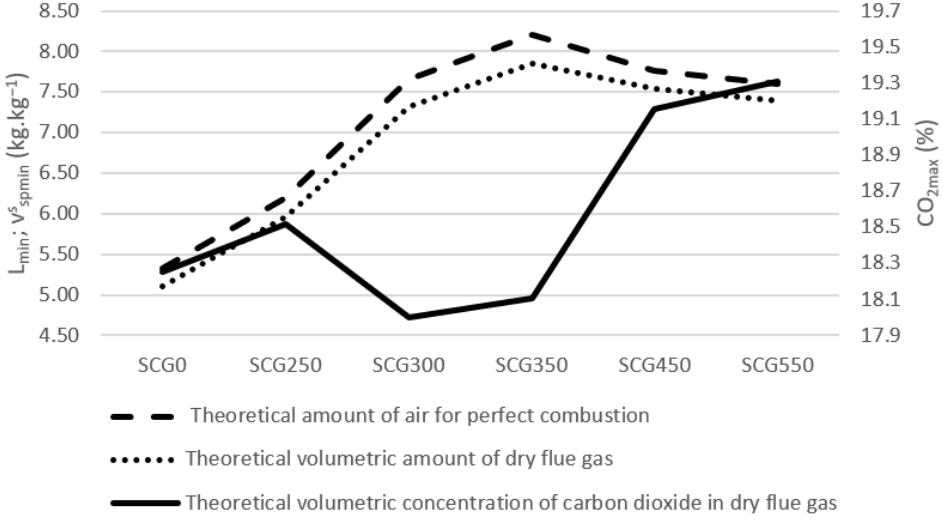
Figure 7. Volumetric combustion of spent coffee grounds.